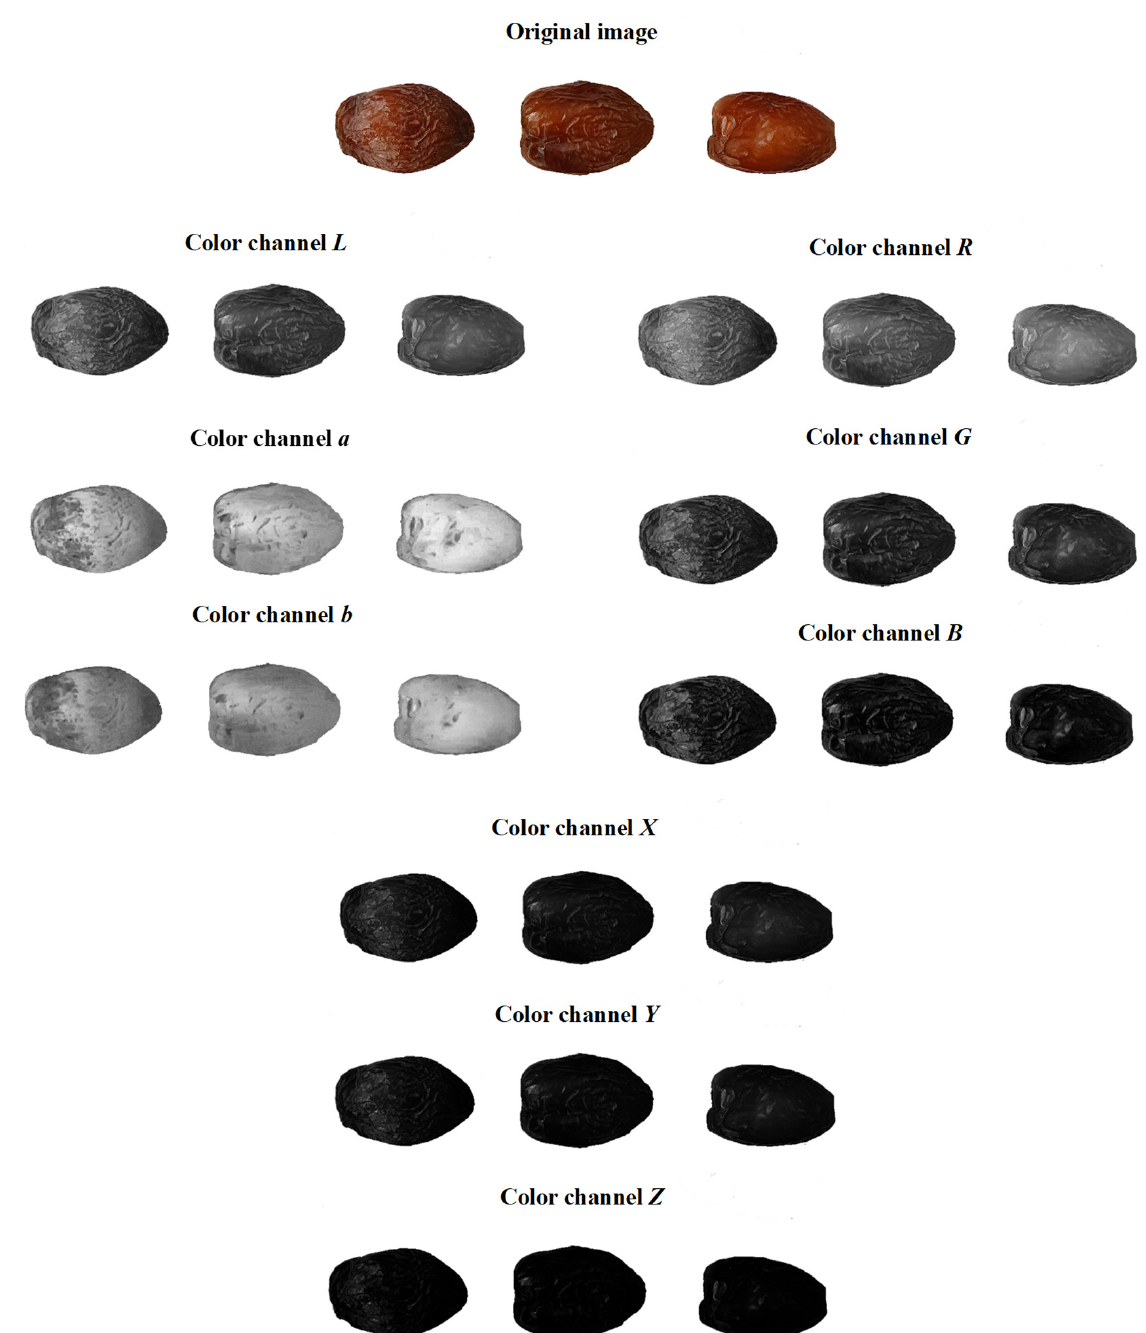
Figure 2. ‘Mejhoul’ date fruit images converted to different color channels.